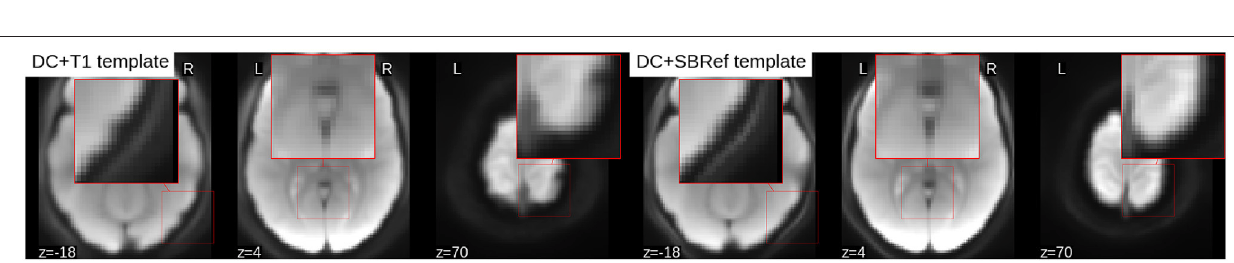
EPI images of a subject to their T1 image via